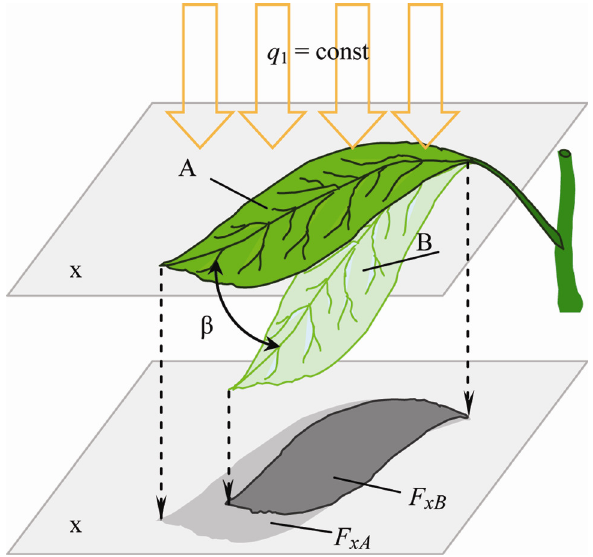
Fig. 1. Chart of a changing plant leaf position with respect to the Sun’s